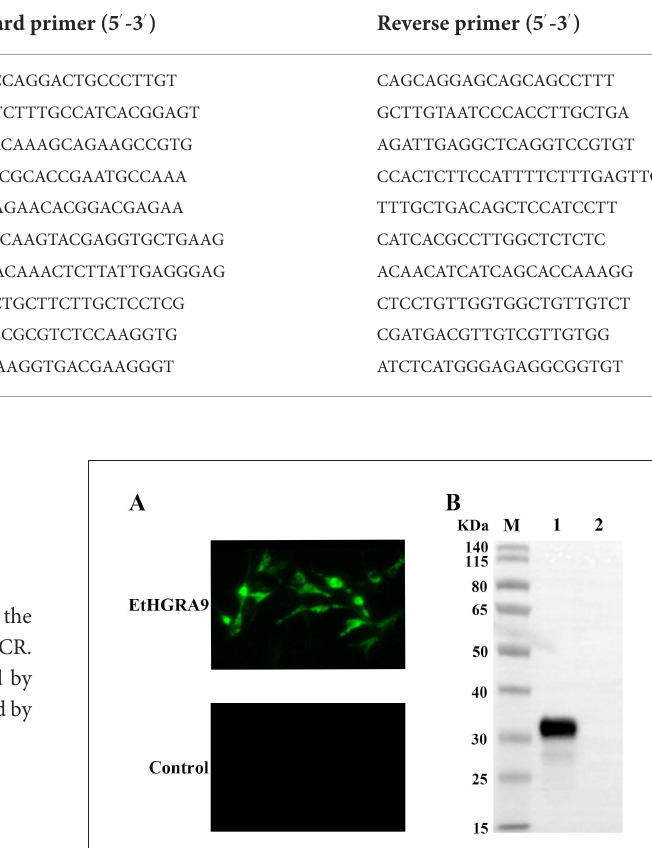
TABLE 1 Primer sequences used in the present study.